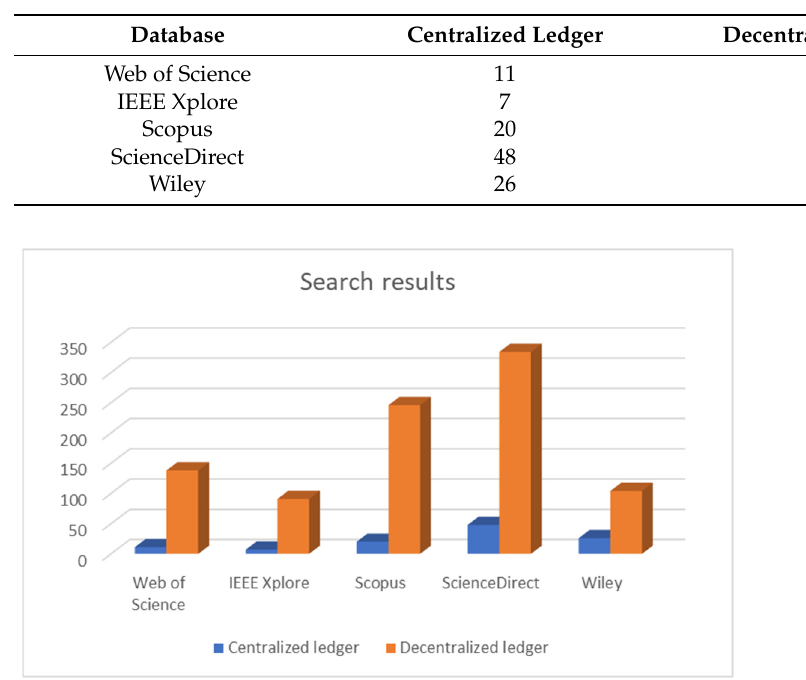
Table 2. Number of papers found for each database.